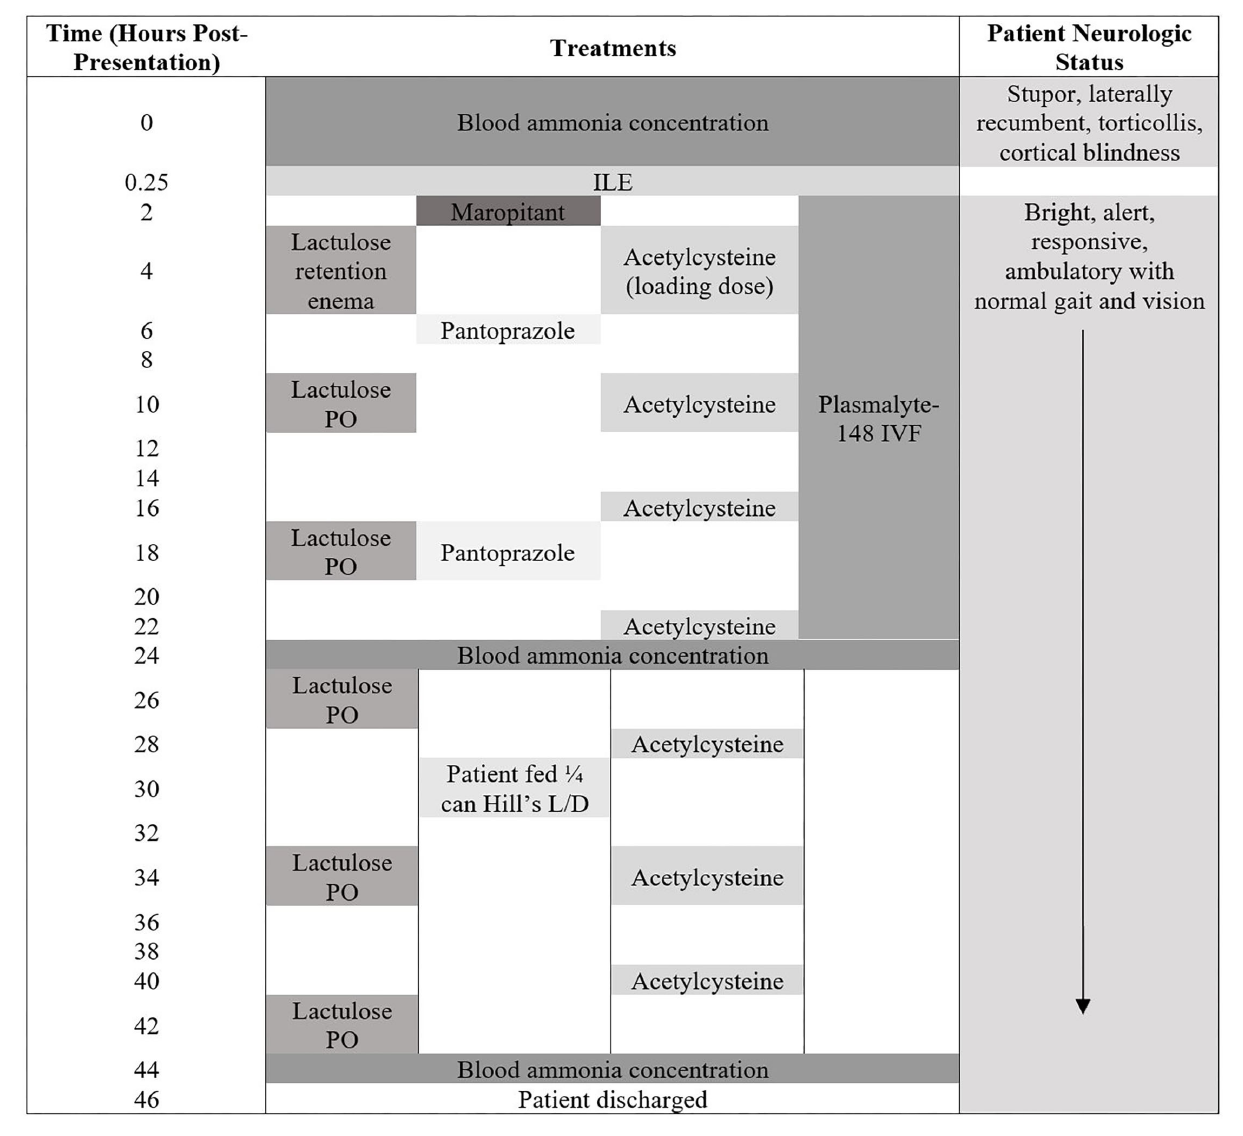
FIGURE 1 | Patient neurologic status and treatments administered from the time of presentation until hospital